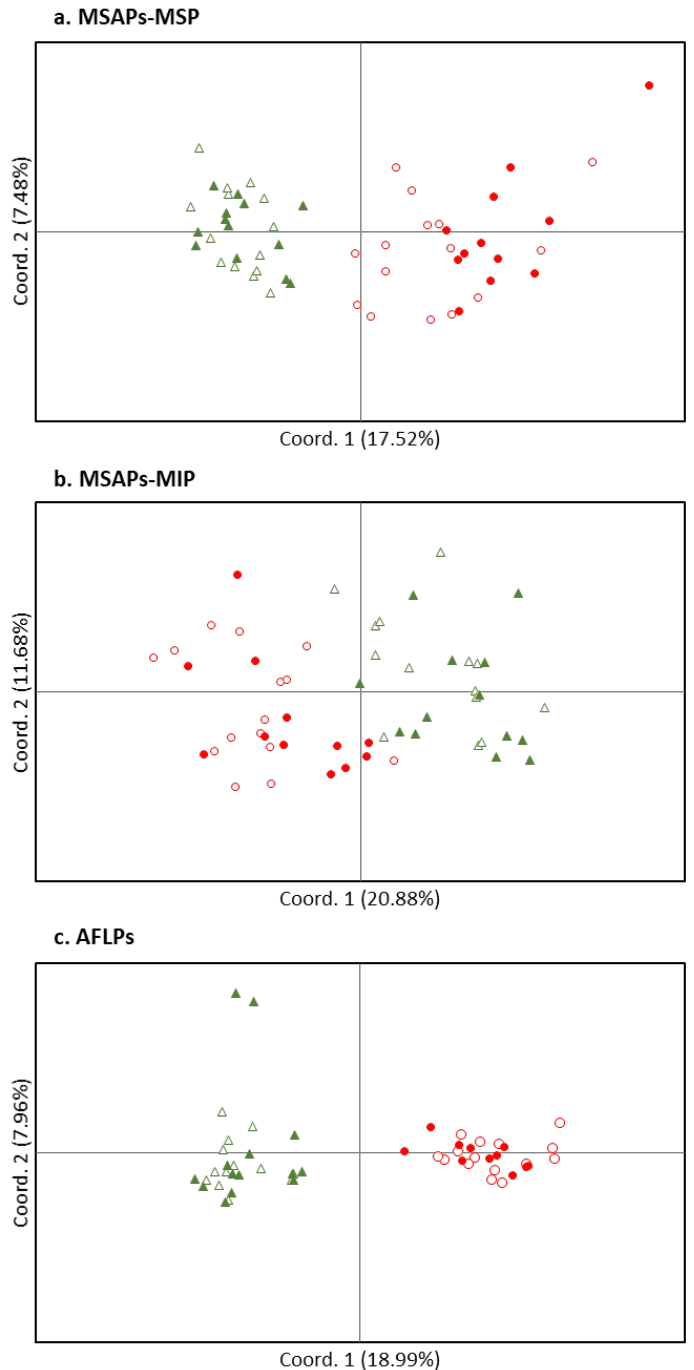
Figure 4. Principal Component Analyses (PCoA) of Spanish (red circles) and Swedish (green triangles) provenances based on MSAP-MSP ( a ), MSAP-MIP ( b ), or AFLP ( c ). The explained variance percentages for each coordinate are shown in brackets. Well-watered (solid symbols) and water-stressed (open symbols) seedlings.